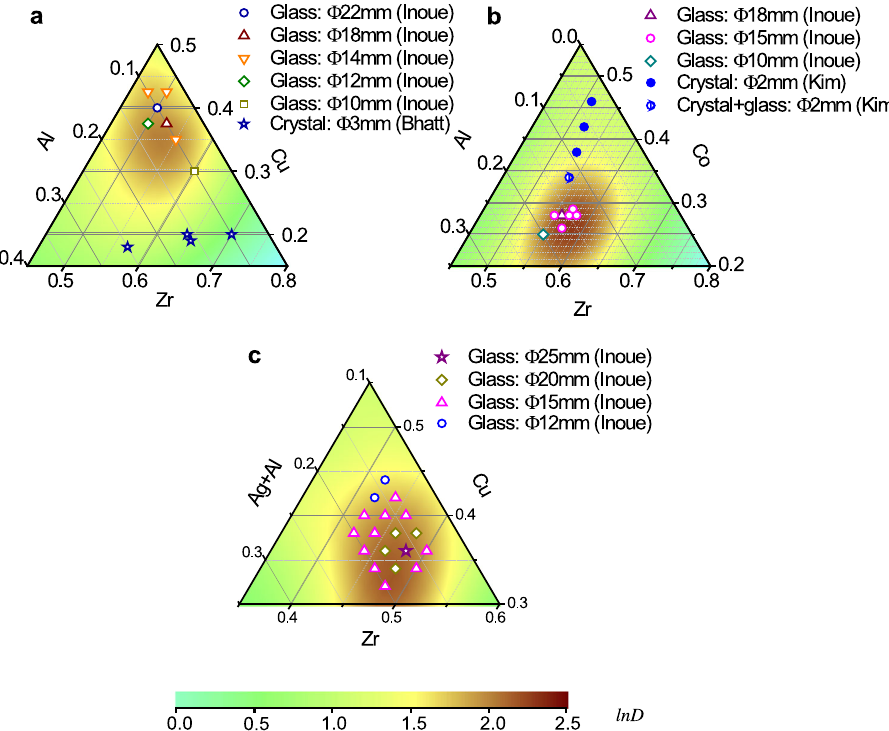
Fig. 2 Comparison of the GFAs predicted by the RQGPR model with those of ternary or quasi-ternary alloys. a Comparison of the predicted GFAs of the Zr – Cu – Al alloys with the experimental results taken from the works of Inoue et al. 64 and Bhatt et al. 65 , b comparison of the predicted GFAs of the Zr – Co – Al alloys with the experimental results taken from the works of Inoue et al. 64 and Kim et al. 66 , and c comparison of the predicted GFAs of the Zr – Cu – (Ag, Al) alloys with the experimental results taken from the work of Inoue et al. 64